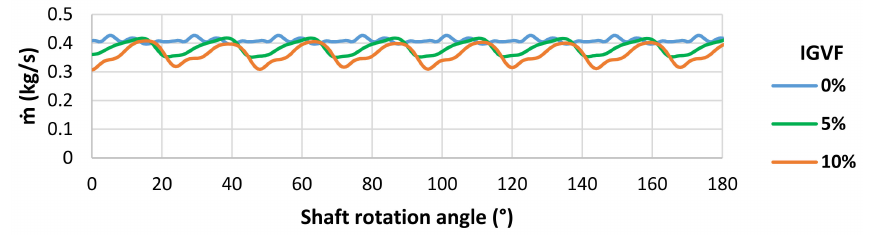
Figure 31. Outlet mass flow ripple CFD data for the IGP at p 2 = 5 bar pressure load, 20 ◦ C oil temperature and 2000 rpm at different